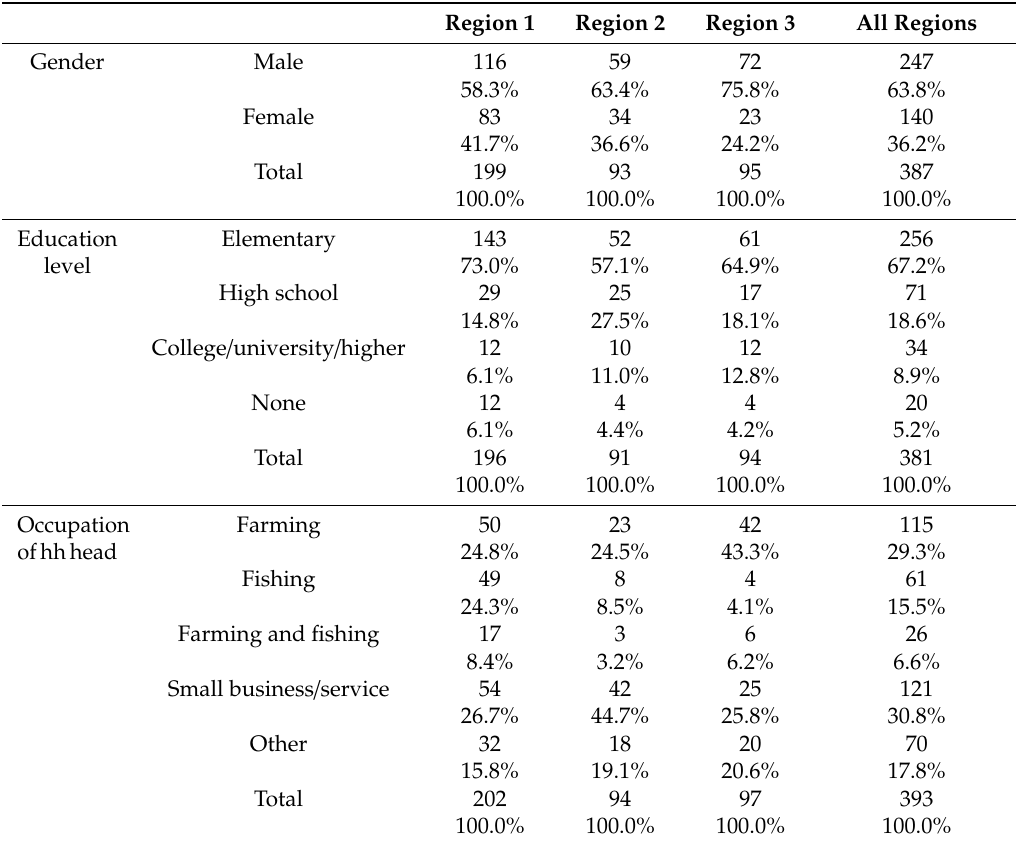
Table A1. Socio-economic characteristics of household